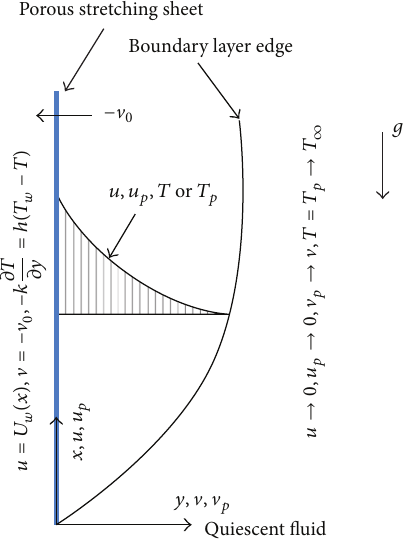
Figure 1: Geometry of the